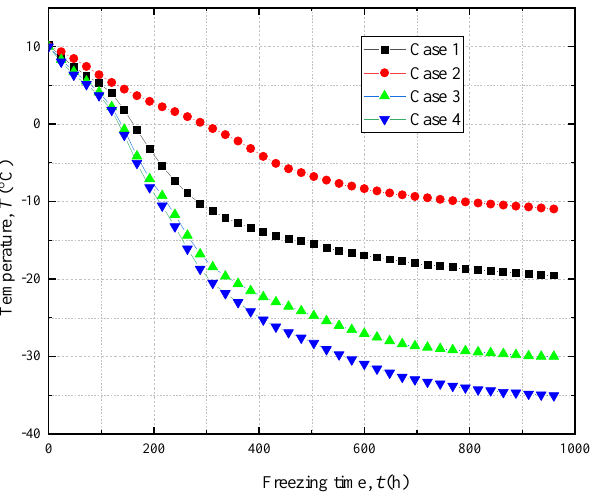
Figure 9. Temperature variation curves at the observation points during freezing at different final temperatures.